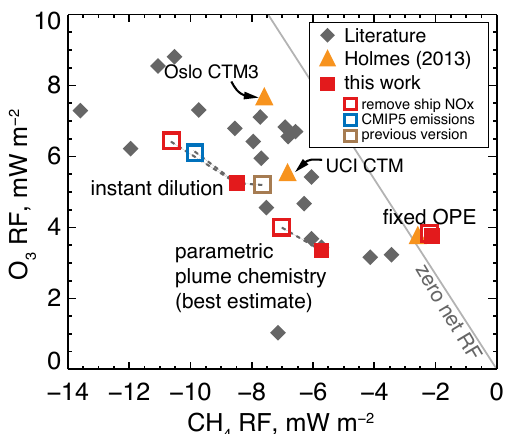
Figure 5. Steady-state RF (mWm − 2 ) from O 3 and CH 4 caused by ship NO x emissions. Values are scaled to emissions of 1Tg(N)yr − 1 . Dashed lines link estimates that are made with 5% increases in ship NO x (filled squares) to others made with the same plume dilution and chemistry assumption (open squares). These other estimates use CMIP5 emissions, a previous GEOS-Chem model version, and complete removal of ship NO x emissions. The zero net RF line accounts for long-lived O 3 changes that enhance the CH 4 RF by approximately 34% (Eq. 4). Literature values are from studies listed in Tables 2 and